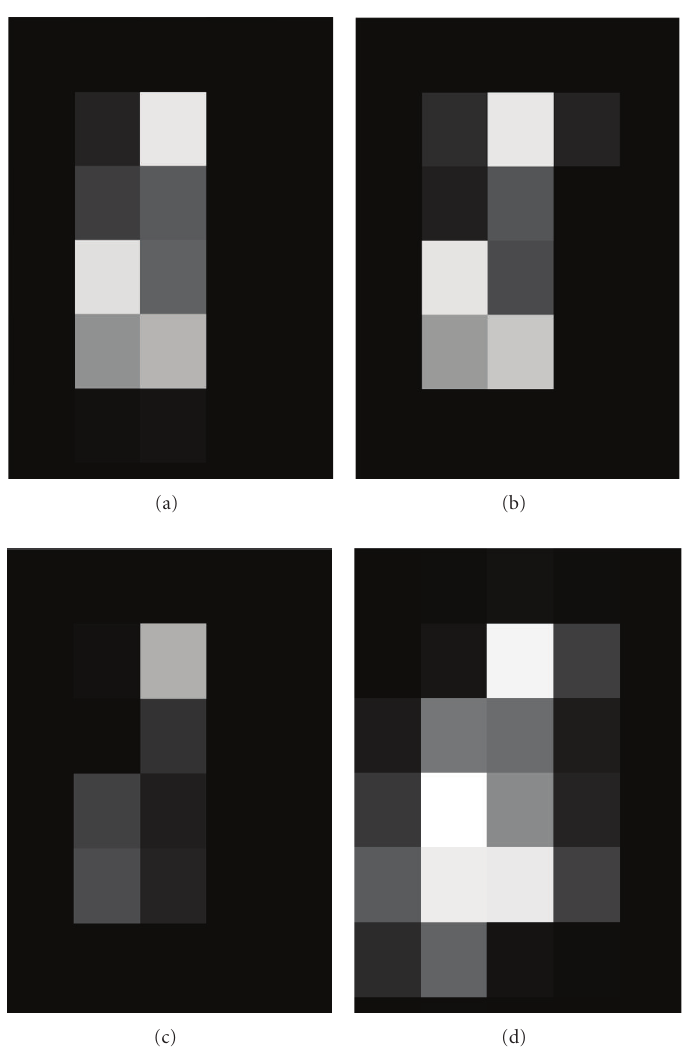
Figure 5: Uniqueness of the cell quantification model. A low-resolution cluster image (a) is shown compared to the best fit (b) containing four model cells. Results for three cells (c) and five cells (d) are clearly inferior. LSQ error equals 145, 231, and 386 gray values for images (b), (c), and (d),